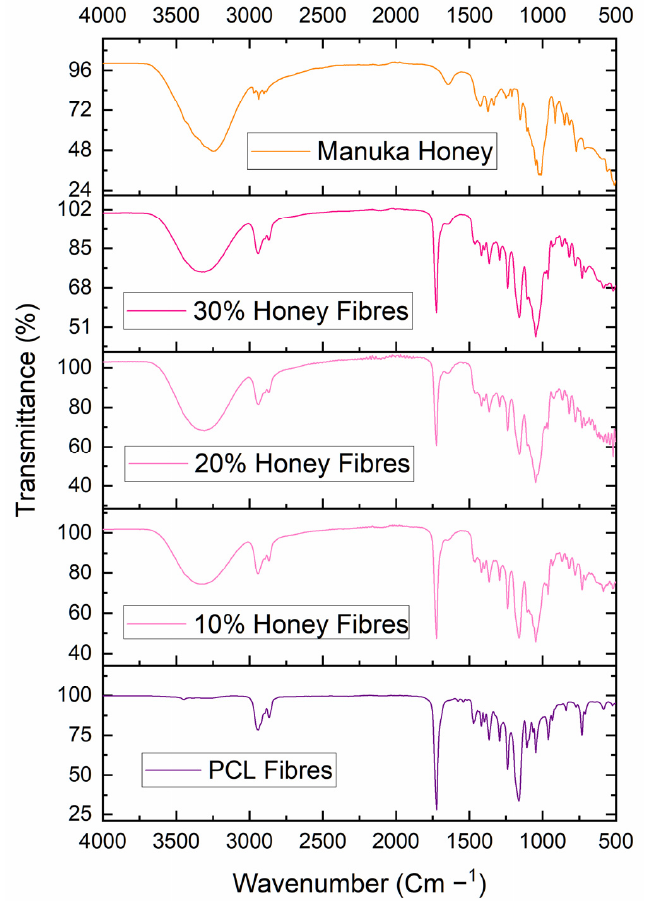
Figure 6. FTIR spectra of virgin PCL fibres, 30% honey-loaded fibres and of pure manuka honey. Specific peaks associated with manuka honey and with PCL are highlighted using arrows in the composite fibres.